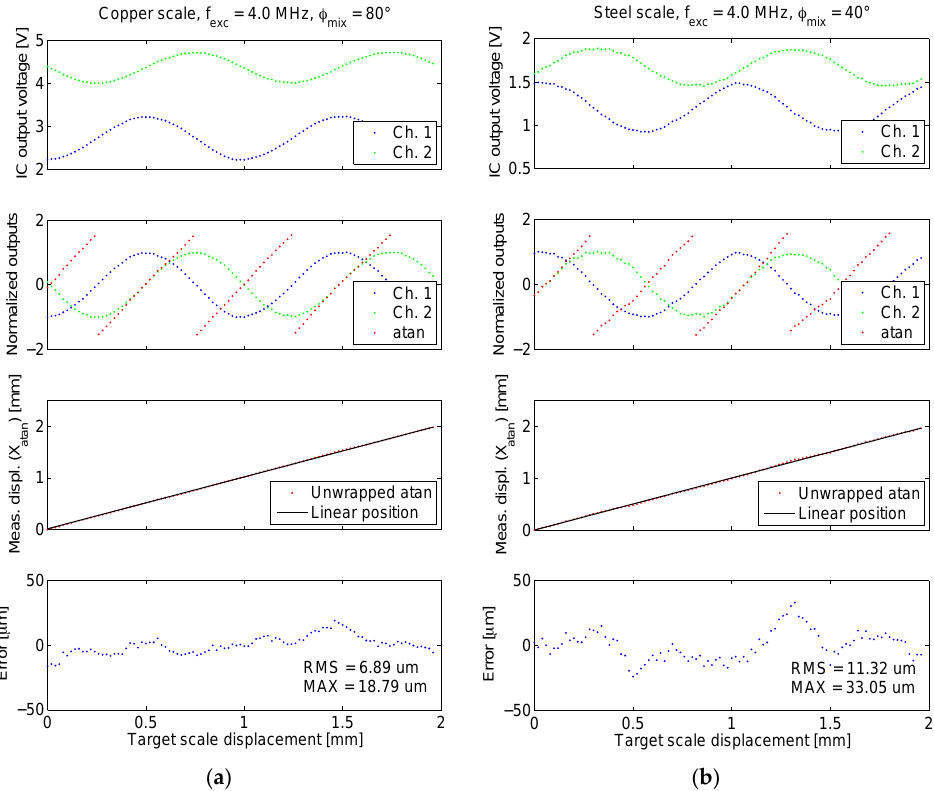
Figure 15. The results of the microsystem linear displacement characterization at optimal excitation frequency and mixing signal phase for each scale type. Results for two scale period lengths are shown. The unwrapped arctangent function for the normalized sensor outputs is also shown, along with errors relative to the reference linear position. ( a ) Results for copper scale; ( b ) Results for steel scale.